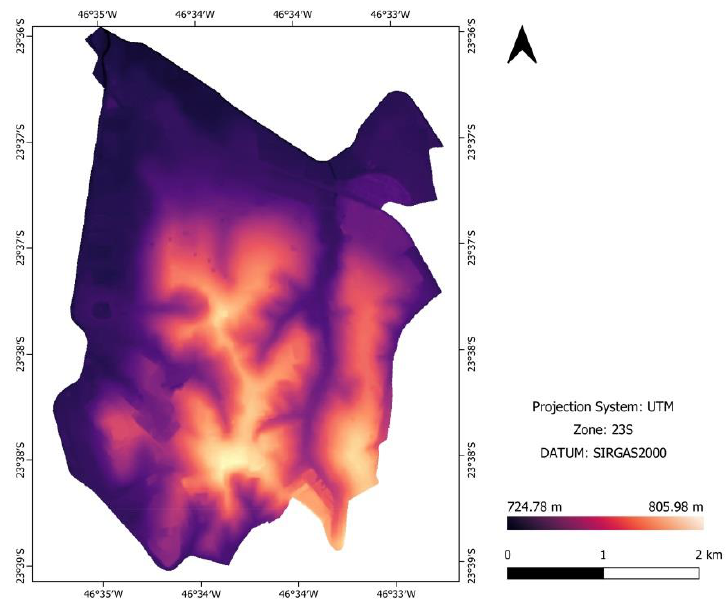
Figure 5. DEM generated through photogrammetric stereoscopic procedures using aerial VNIR orthophotos. This DEM was used as input for generating the map of floodable areas.